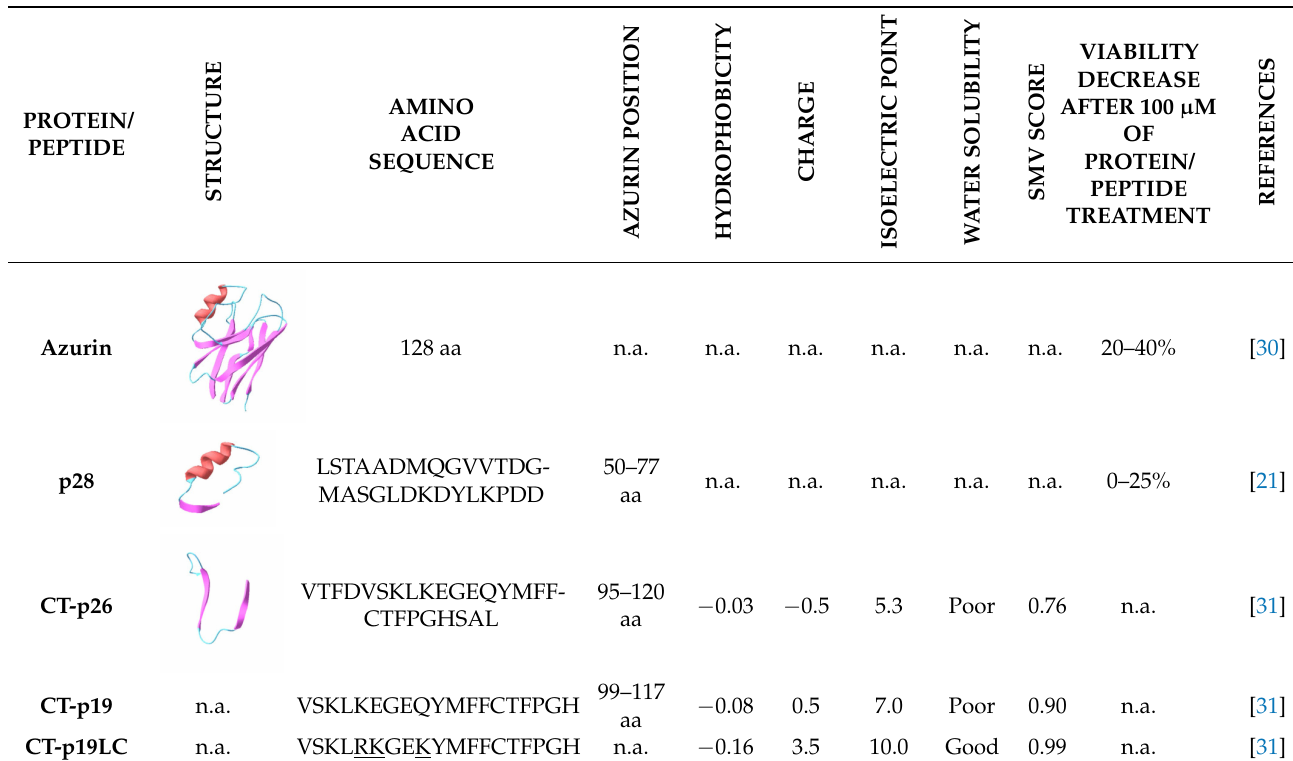
Table 1. Overview of the characteristics of azurin and its derived